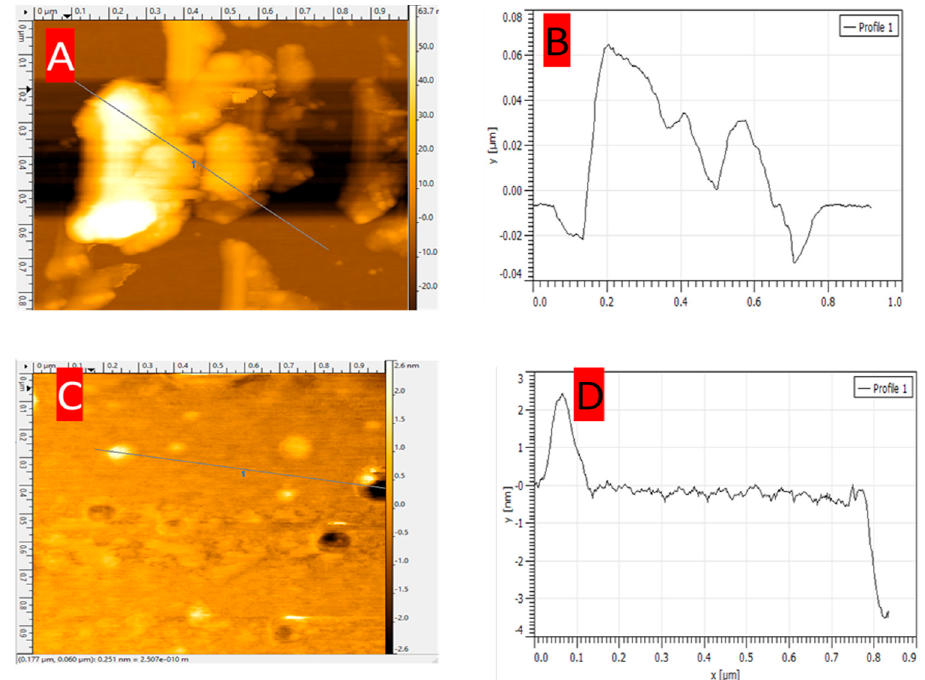
Figure 6. Structure study of electrophoretic deposited ZnO NPs. We examined the surface uniformity and roughness by atomic force microscopy (AFM). 2D AFM images of the ZnO thin films EPD with different applied voltage: ( A ) 10 V; ( B ) Surface profile of the blue line on ( A ); ( C ) 60 V with APTES; and ( D ) Surface profile of the blue line on ( C ).